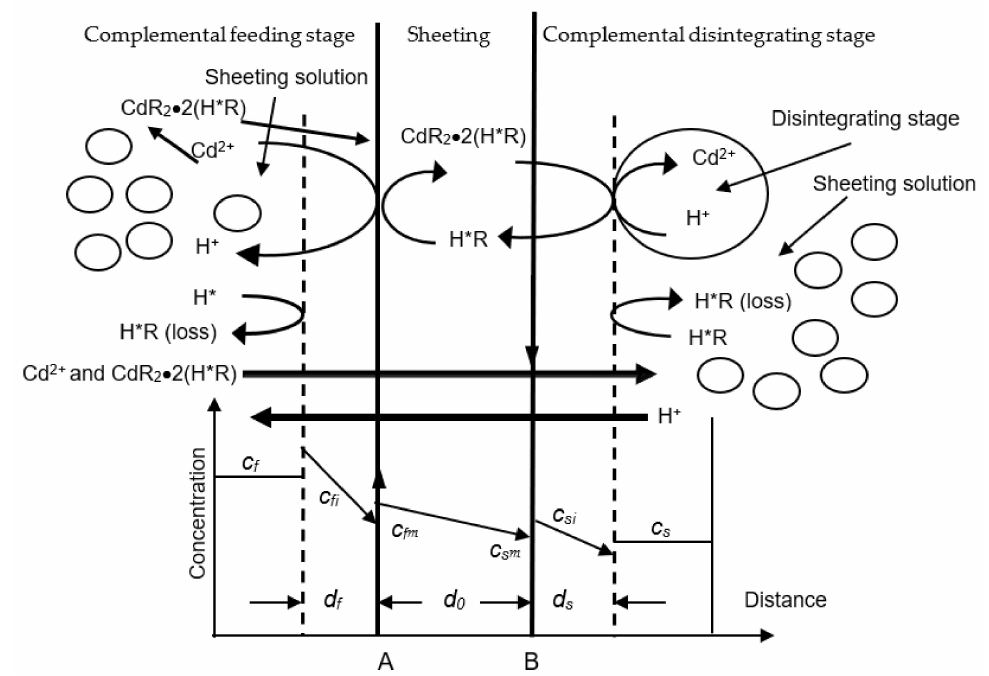
Figure 1. Principle schematic of Cd(II) dislodging through the diphasic sheeting device. H*R represents the Cyanex-301 within the sheeting. CdR 2 • 2(H*R) represents the organic metallic com- pounds, H + is the hydrogen ion, and Cd(II) represents the divalent cadmium ions (A and B are the sheeting